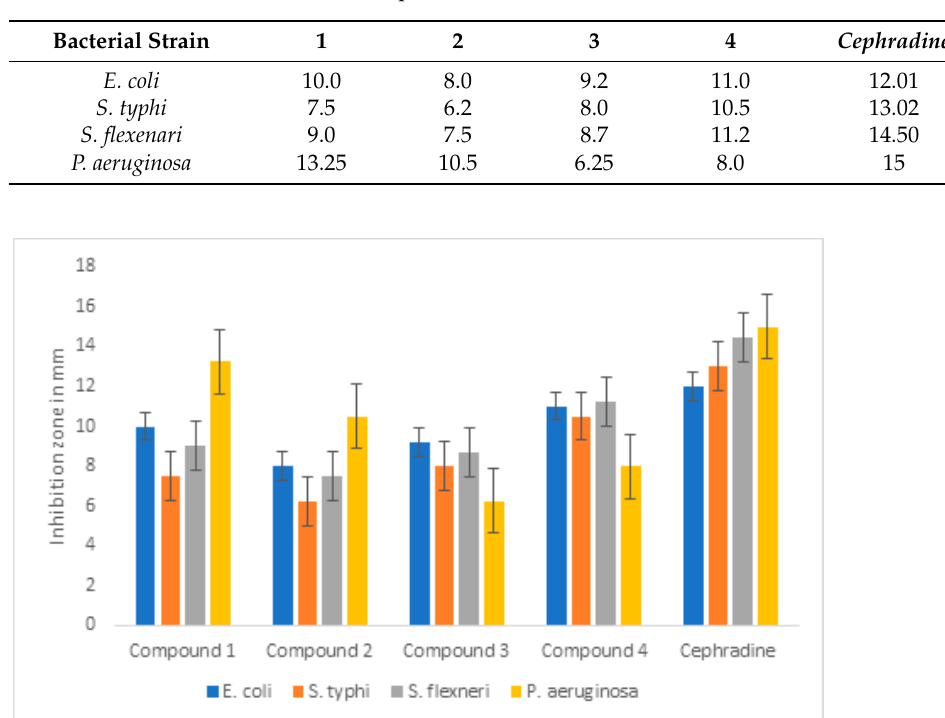
Figure 7. Graphical representation of antimicrobial activities of compounds 1–4.